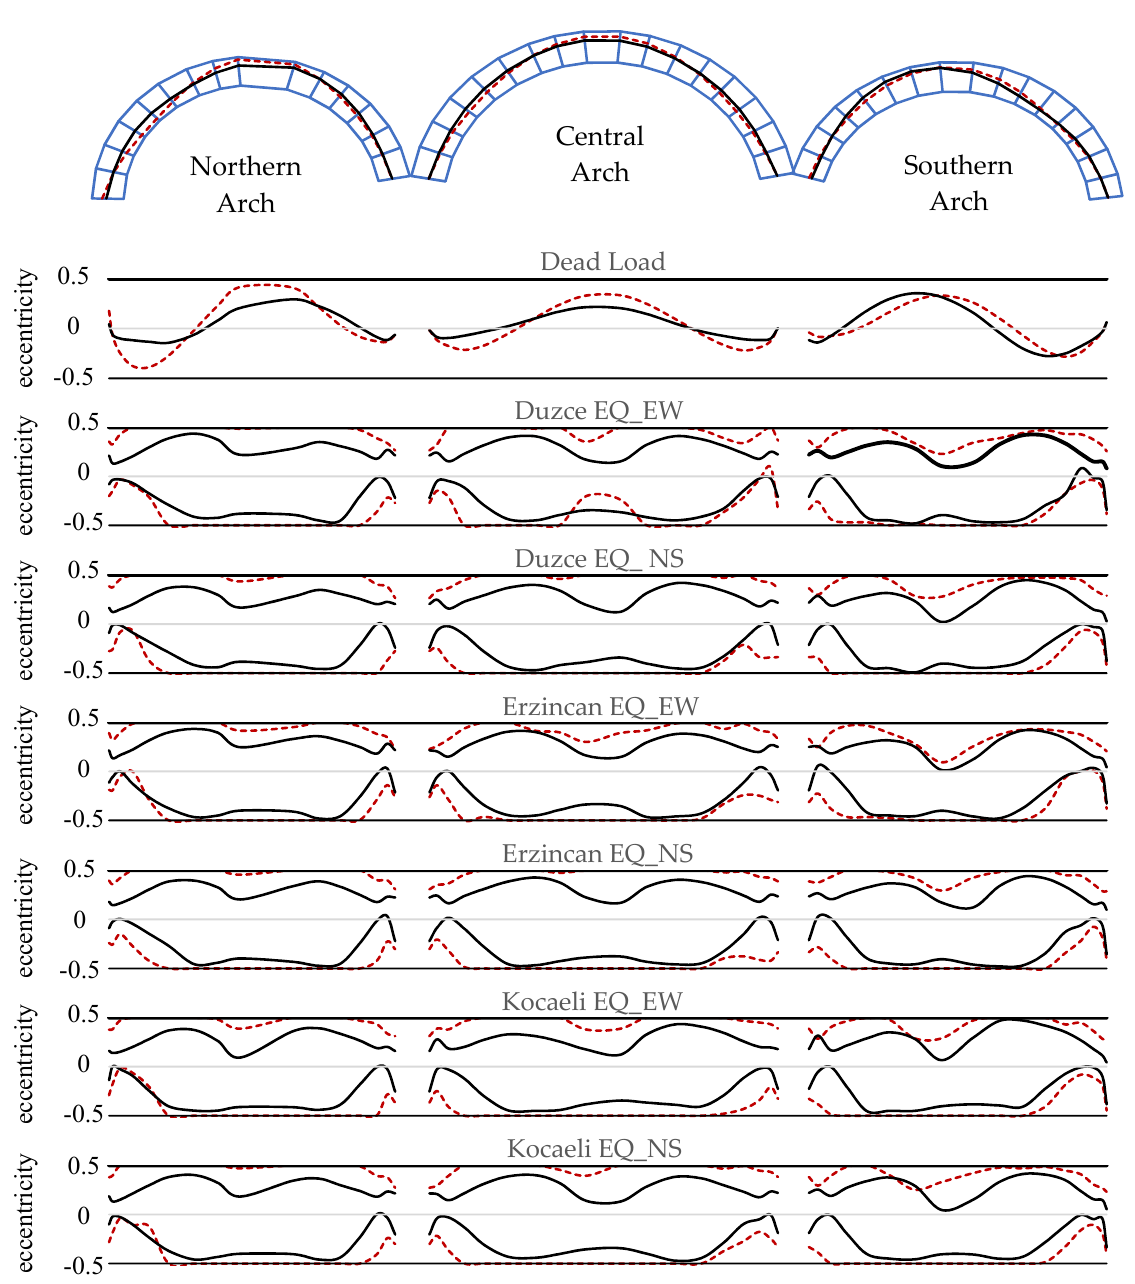
Figure 15. Backbone eccentricity curves (dotted lines: existing bridge, continuous lines: retrofitted bridge). The behavior of the existing and restored bridges was also compared using the re- sponse of a selected interface located at the northern arch. Figure 16 expresses the shear demand on the interface as a time-dependent friction coefficient as well as the eccentricity value for both cases along with the limit values. Although the exceedance of the defined limit for an individual interface does not indicate failure, the reduction in the rotation and the sliding demands were apparent for the restored bridge. These results show that the bridge, in its current state, would not meet the expected seismic performance standard for the defined hazard level, yet the restored bridge performs satisfactorily without going into a failure mechanism through the formation of hinging and sliding at the interfaces.